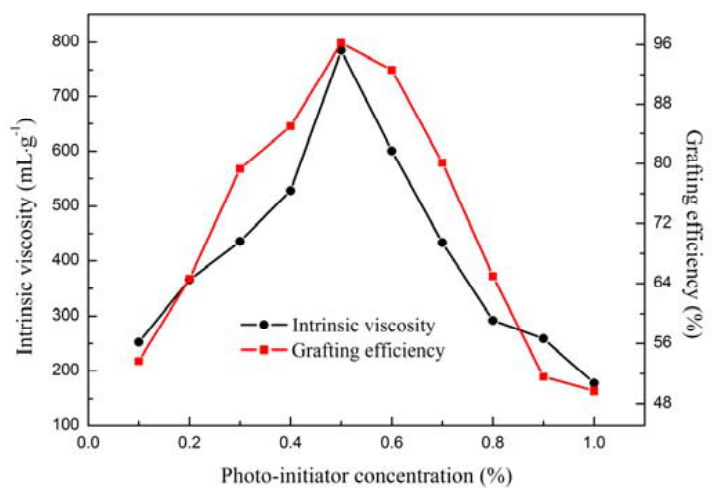
Figure 4. Effect of photo ‐ initiator concentration on Intrinsic viscosity and Grafting efficiency of CPCTS ‐ g ‐ P (CTA ‐ DMDAAC).